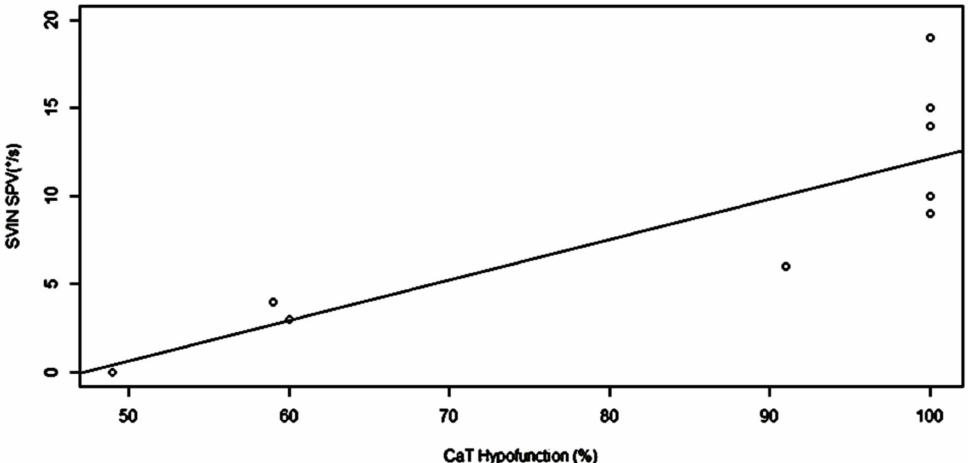
Figure 3. Regression graph between SVIN-SPV (horizontal canal component) and caloric test (CaT). Hypofunction in %. Statistical results are as follows: beta = 0.23067; standard error = 0.05647; p = 0.00351; R 2 = 0.63. The SVIN-Hor SCC is correlated with the caloric test, which is a marker of the HSCC